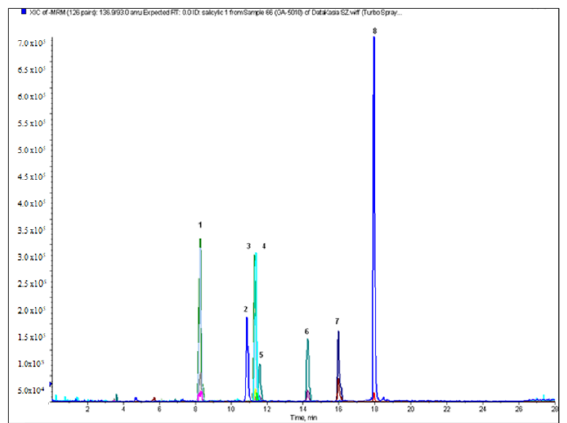
Figure 1. The chromatogram in MRM mode of phenolic acids in the ethyl acetate extract of the aerial parts of A. acutiloba (AH-O): 1-protocatechuic acid; 2-4-hydroxybenzoic acid; 3-gentisic acid; 4-caffeic acid; 5-syringic acid; 6- p -coumaric acid; 7-rosmarinic acid; 8-salicylic acid.